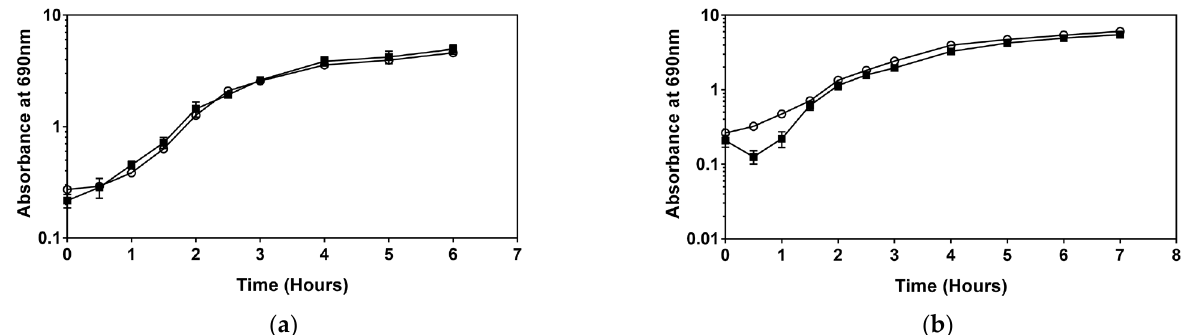
Figure 2. Growth comparison of supplementation with sub- MIC levels of DDAC (●) and without DDAC ( ○ ): ( a ) Serratia marcescens ATCC 13880; ( b ) Serratia sp. HRI.